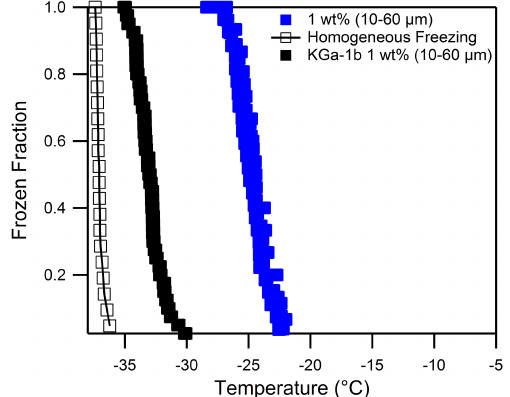
Figure 9. Frozen fraction curve for 1wt% Na / Ca feldspar in 10– 60µm droplets as a function of